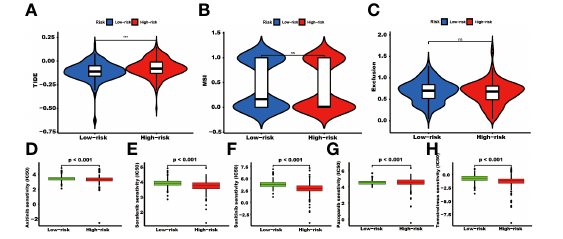
FIGURE 8 The TIDE score and targeted agents ’ treatment sensitivity. Tumor tissues in the high TRGs risk group present the high TIDE score (A) , and the MSI and Expulsion score has no signi fi cant difference in these two groups (*** represents p<0.001, ns represents no signi fi cant difference). (B, C) . The treatment response of targeted agents, axitinib (D) , sorafenib (E) , sunitinib (F) , pazopanib (G) , and temsirolimus (H)